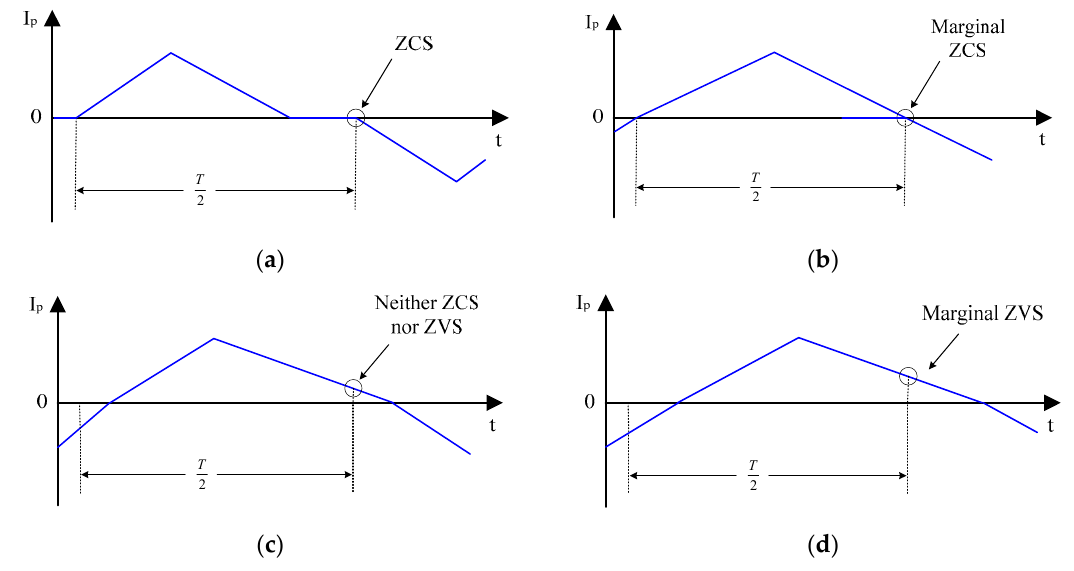
Figure 5. Load Current for ZCS and ZVS: ( a ) ZCS; ( b ) Marginal ZCS; ( c ) Neither ZCS nor ZVS; ( d ) Marginal ZVS.